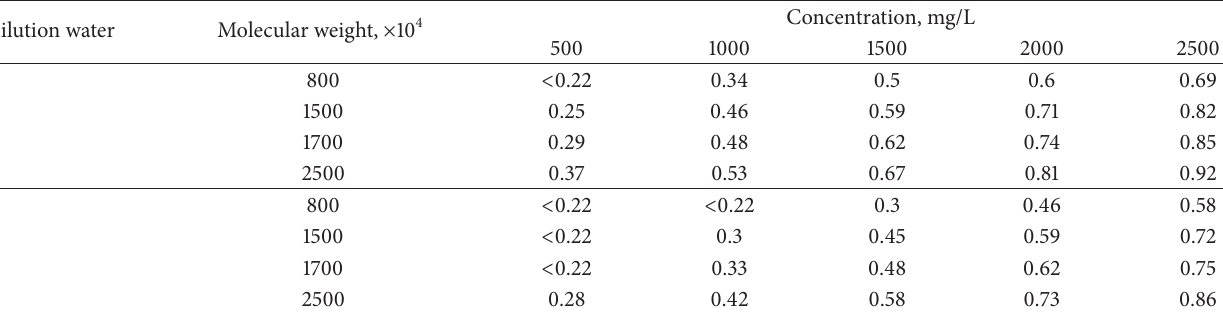
Table 2: The hydrodynamic characteristic size, 𝜇 m.